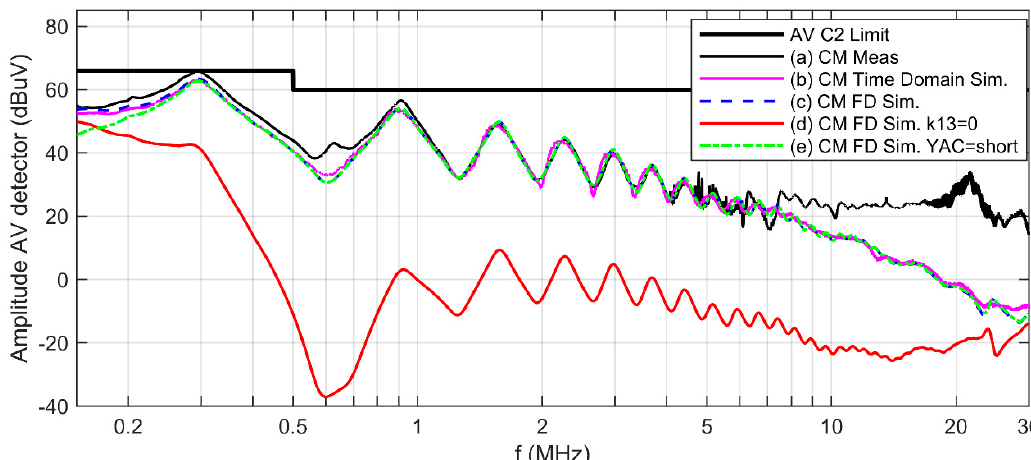
Figure 8. Simulated and measured conducted emissions of CM noise. Simulation (b) used the full three-phase circuit shown in Figure 2, simulations (c)–(e) used the common mode circuit shown in Figure 6 with frequency-domain (FD) solver. The setup uses a 100 m motor cable (16 mm 2 ).